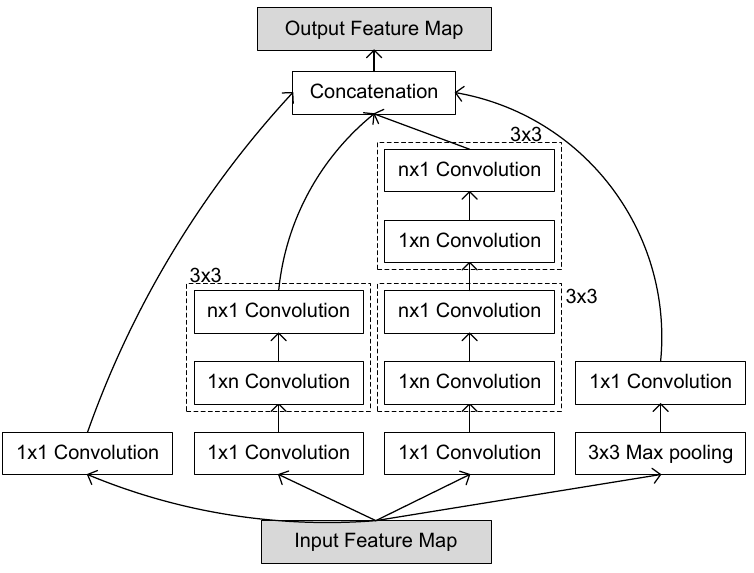
Figure 2. Architecture of the Inception-v2 module of